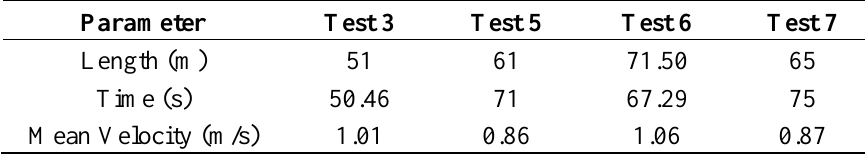
Table 6. Comparisons between more complex